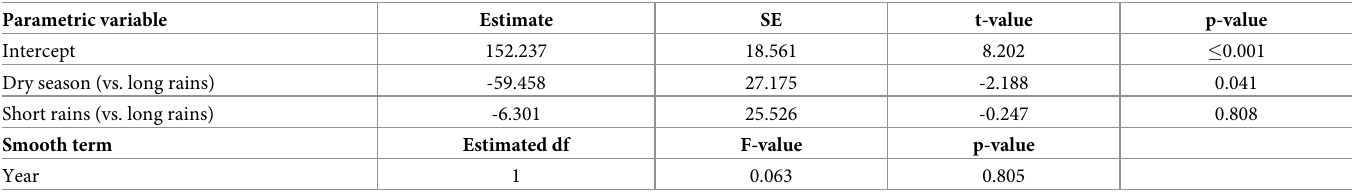
Table 2. Parameter estimates of a generalized additive model to describe annual and seasonal trends of olive baboon densities in Lake Manyara National Park, Tanzania. Parametric